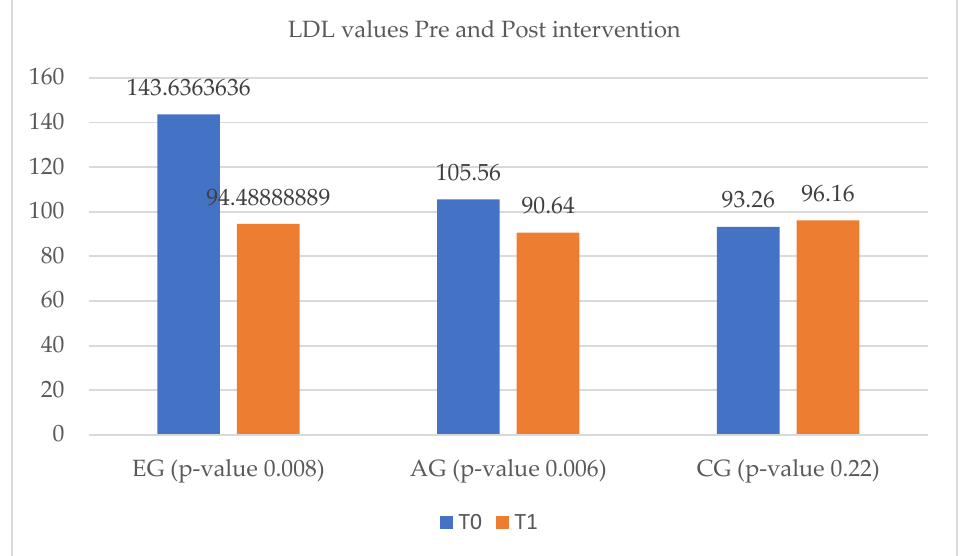
Figure 2. LDL cholesterol values in the heart failure study group. EG = experimental group; AG = ambulatory group; CG = control group; T 0 = before the rehabilitation period; T 1 = after the rehabilitation period.